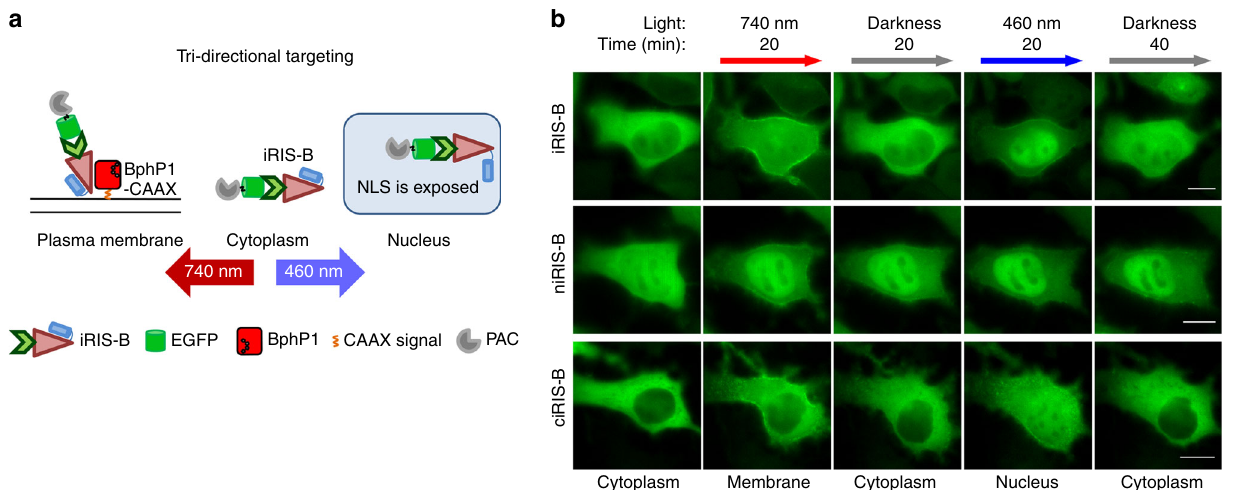
Fig. 2 Optogenetic system for three-directional targeting of endogenous proteins. a Mode of function of an optogenetic system for the light-controlled tridirectional targeting of endogenous proteins, iRIS-B. b Sequential relocalization of EGFP-PAC via iRIS-B (upper), niRIS-B (middle), and ciRIS-B (lower) after irradiation with light of indicated wavelength and recovery due to thermal relaxation. Epi fl uorescence microscopy; scale bar, 10 μ m. Kinetics of EGFP- PAC depletion in cytoplasm, or accumulation in the nucleus via iRIS-B, niRIS-B and ciRIS-B are shown in Supplementary Fig. 4.